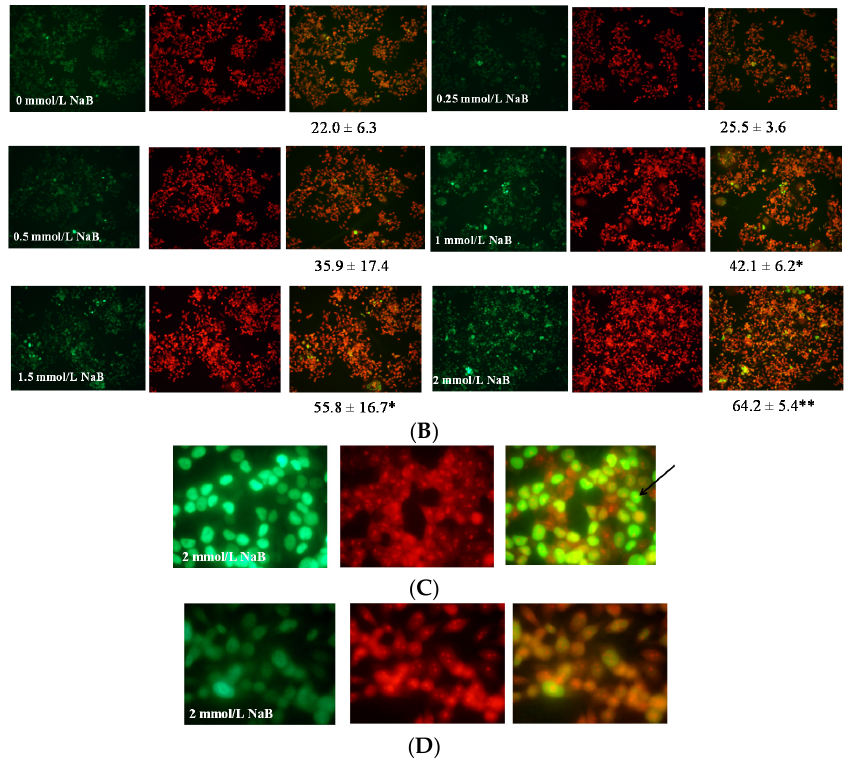
Figure 5. Effect of sodium butyrate (NaB) treatment for 15 h on p21 protein level and distribution at cellular level in HCT116 and NCM460 colon cells. Each sample consists three images: image 1, cells were labeled with anti ‐ p21 antibody, and followed by anti ‐ Rabbit IgG (H and L), F(ab’) 2 Fragment (Alexa Fluor ® 488 Conjugate) (green signals); image 2, cells were mounted by fluoroshield with PI as counter staining for overall cell morphology ‐ background (red signals); image 3, the p21 protein image was superimposed on the respective overall cell morphology ‐ background image to generate the composite image (orange signals). ( A ) HCT cells at 200× magnification; ( B ) NCM460 cells at 200× magnification; ( C ) HCT116 cells with intense p21 expression around the nucleus (arrow) at 1000× magnification; ( D ) NCM460 cells at 1000× magnification. For panel ( A , B ) composite images, the area of p21 protein level (green signals) in percentage when compared with that of overall cell morphology ‐ background (red signals). Values are means ± SD, n = 4. There was a significant interaction between cell type and concentration ( p < 0.001) by two ‐ way ANOVA. * Different from control (0 mmol/L NaB); * p < 0.05, ** p < 0.0001.